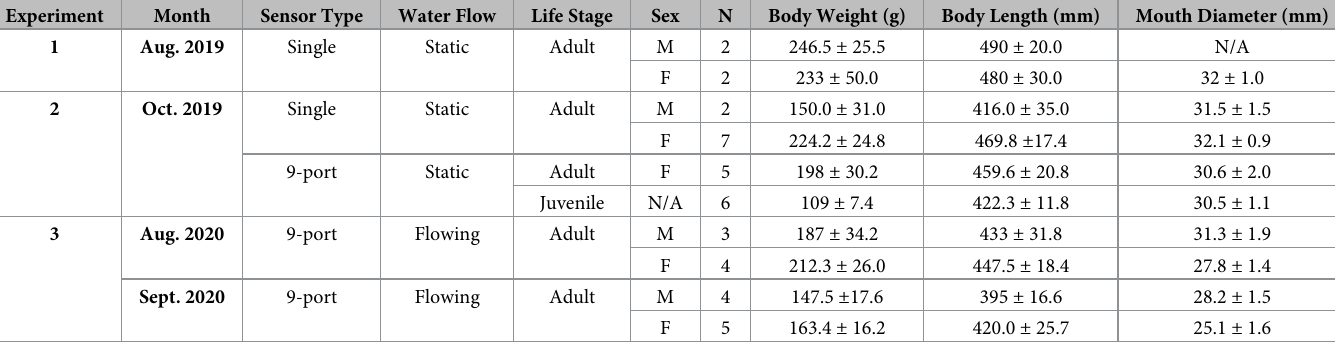
Table 1. Summary of vacuum pressure tests of live sea lampreys, including months, instruments used (sensor type), flow conditions (water flow), and biological var- iables (life stage, sex (M = male; F = female; N/A = unavailable), number of individuals (N), body weight, body length, and mouth diameter).